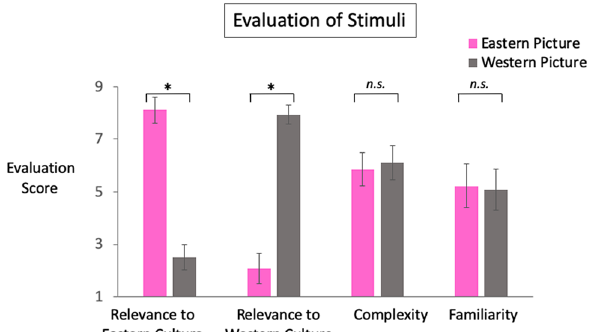
Figure 4. Evaluation results of the Eastern and Western picture stimuli. The Eastern picture stimuli showed higher relevance to the Eastern culture than that of the Western culture, while the Western picture stimuli showed higher relevance to the Western culture than that of the Eastern culture. The Eastern and Western pictures were not different in their complexity and familiarity ratings. * p < 0.05; n.s., not statistically significant.